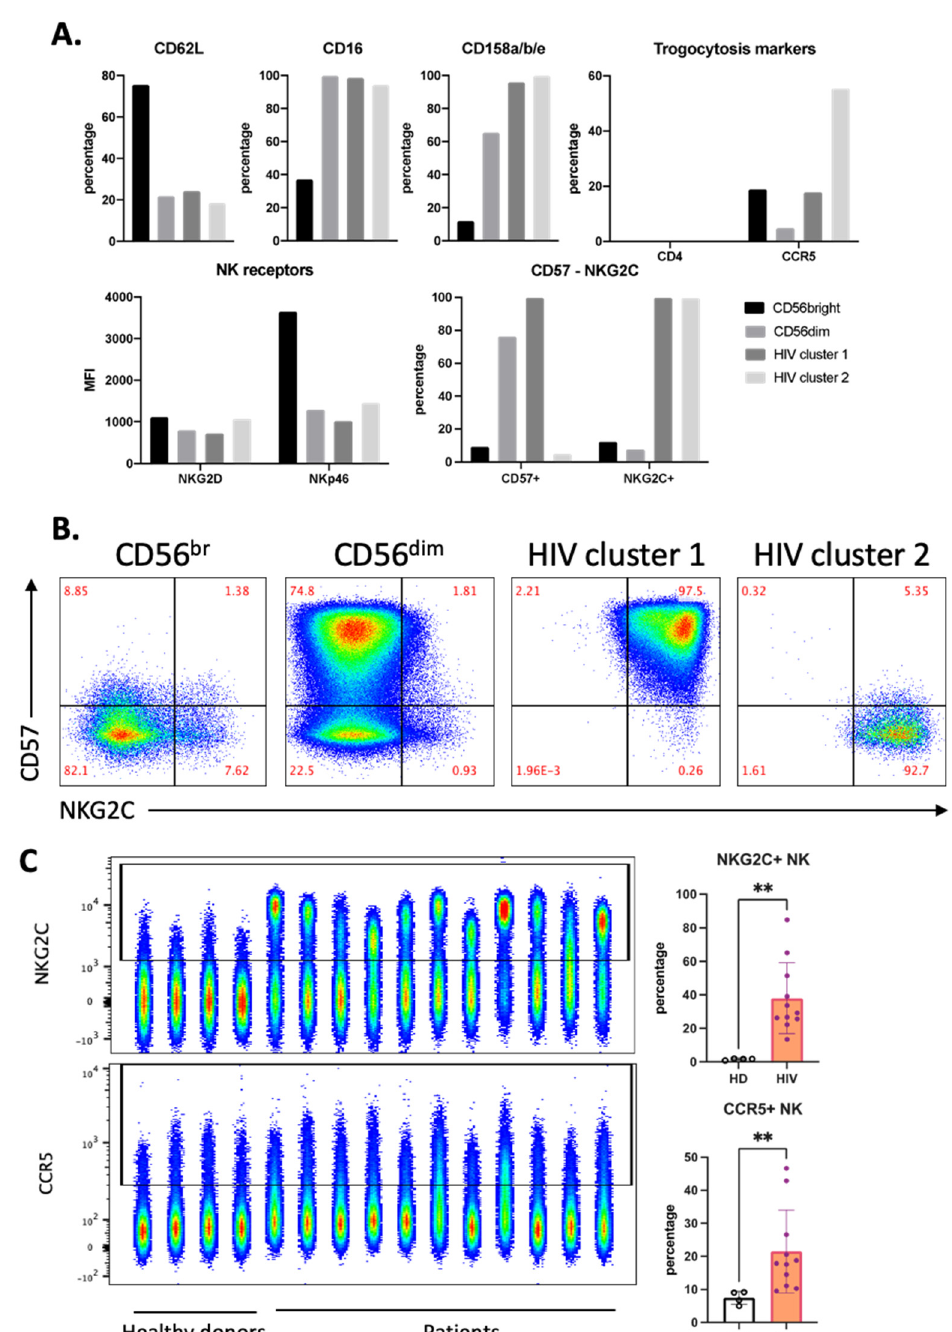
Figure 4. Distinct phenotype of HIV-1-specific clusters in aviremic HIV-1 patients. ( A ) Phenotype of each cluster identified in Figure 3 by percentage and expression level (MFI) of each marker in the panel. ( B ) Manual gating on CD57 and NKG2C for all concatenated NK cells from the HIV-1 patients, which were divided into four clusters, as described in Figure 3B. ( C ) Accumulation of NKG2C + and CCR5 + NK in HIV-1 patients represented by FACS plot (left) and summarized statistics (right). Statistical significance was determined by unpaired t -test; ** p ≤ 0.01.